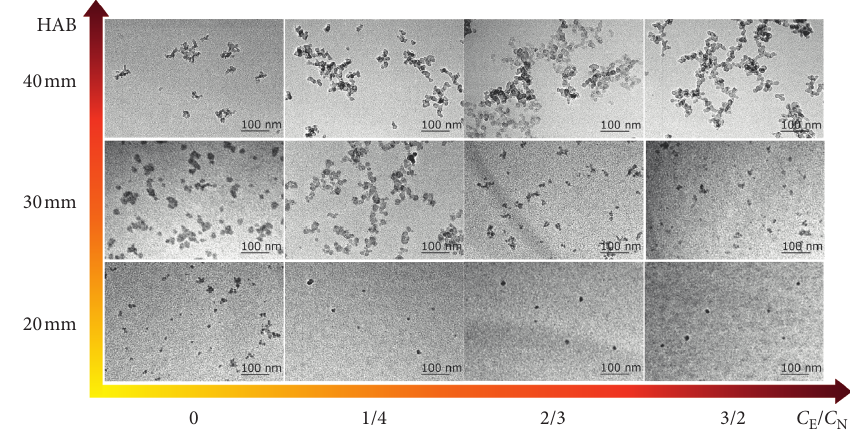
Figure 6: HRTEM image of soot particles in a laminar diffusion flame with n- heptane mixed with